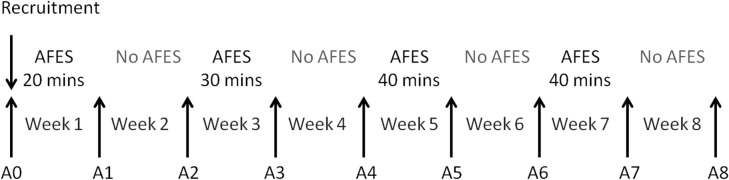
Study time line.